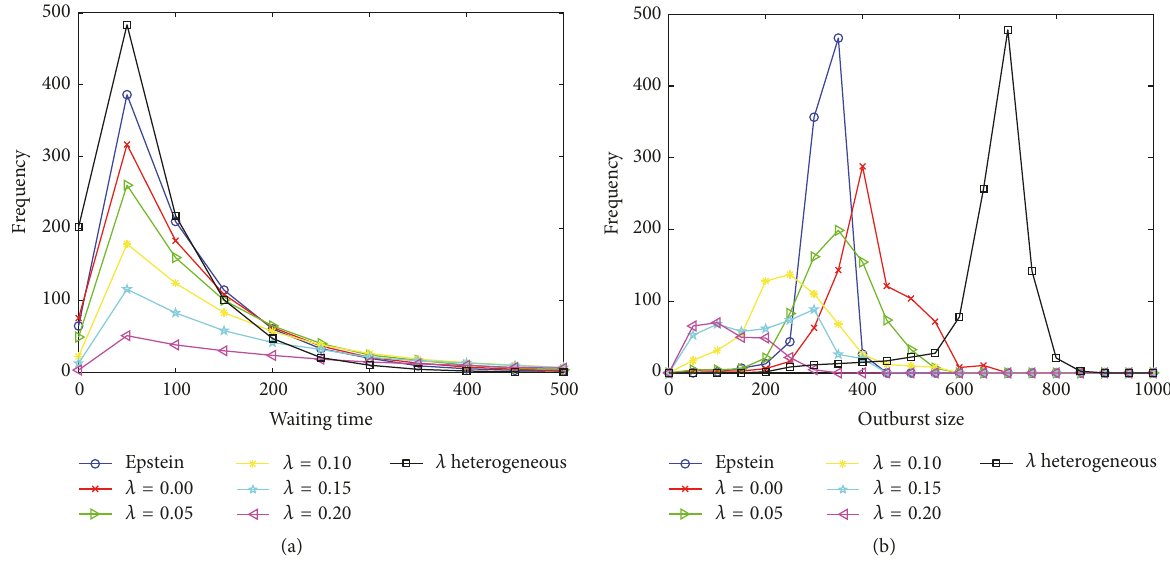
Figure 6: (a) The waiting time distribution with rescaled legitimacy. (b) The outburst sizes distribution with rescaled legitimacy for saving parameters is plotted. The cases with homogeneous saving are drawn with red, green, yellow, magenta, and cyan lines for the values, respectively. The line with squares in black corresponds to the case with heterogeneous saving in the system, while the line with blue circles corresponds to the distribution obtained with the original Epstein